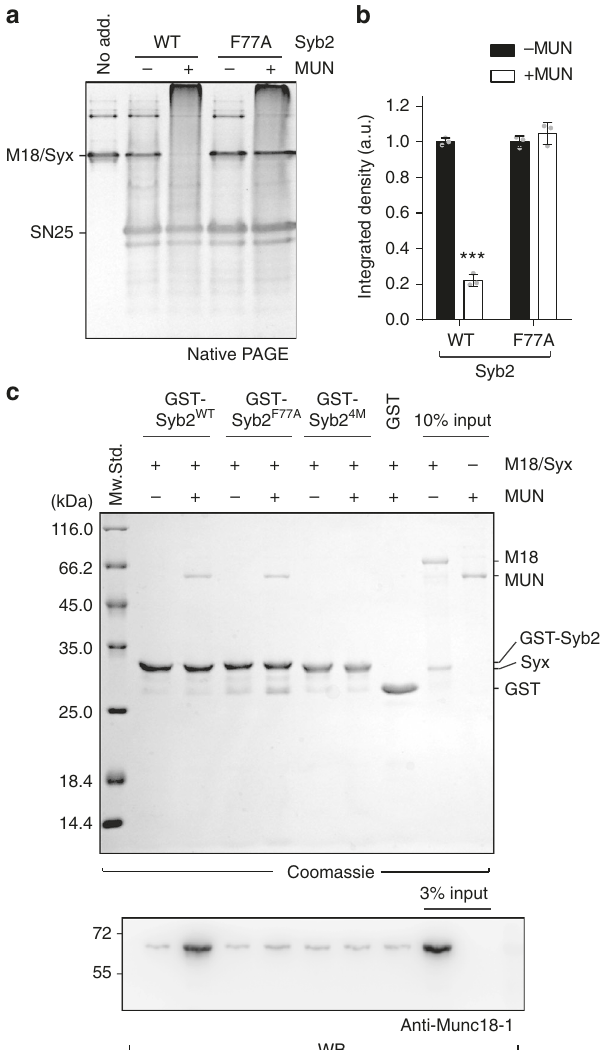
Fig. 6 The MUN domain enables speci fi c binding of Syb2 to the Munc18-1/Syx1 complex. a The F77A mutation of Syb2 severely impairs MUN-catalyzed transition from the Munc18-1/Syx1 complex to the SNARE complex. The representative gel displayed is from one of three replicates. b Quanti fi cation of a . Integrated density represents the normalized integrated gray level of each assessed Munc18-1/Syx1 band. Data are presented as the means±SD, n = 3, two-tailed t test, *** p <0.001. c Binding of Syb2 and its mutations to the Munc18-1/Syx1 complex in the absence or presence of the MUN domain detected by GST pull-down assay combined with immunoblotting. The MUN domain enables an interaction between Syb2 and the Munc18-1/Syx1 complex, and this interaction was able to be disrupted by the F77A or 4M mutation. The representative gels displayed are from one of three replicates. Source data are provided as a Source Data fi